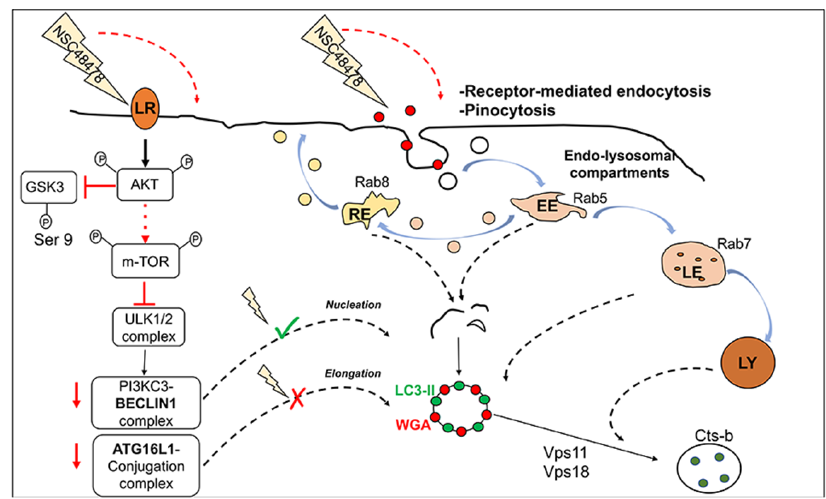
Figure 9. The 37/67 kDa laminin receptor inhibitor, NSC48478, induces the activation of non-canonical m-TOR-independent autophagic pathway. Left part of the scheme: upon NSC48478 administration, we previously demonstrated activation of Akt and GSK3b switch-off. Here, we demonstrate that inhibitor treatment induces phosphorylation of m-TOR (most likely through Akt activation) and does not affect the preforming autophagosome complex ULK1/PI3KC3/BECN1. Upon NSC48478 treatment, knockdown of BECN1 (red arrow) does not affect LC3-positive structures; while knockdown of ATG16L1 (red arrow) affects both formation of LC3 structures and LC3-II. Right part of the scheme: NSC48478 administration induces formation of endosomal structures positive for both LC3 and endocytic marker WGA, together with contribution of Rab 5-7-8. qRT-PCR analysis shows a significant upregulation of Vps11 , Vps18 , and CTSb , indicative of an autophagy event. LR: laminin receptor; RE: recycling endosomes; LE: late endosomes; Ly: lysosomes.